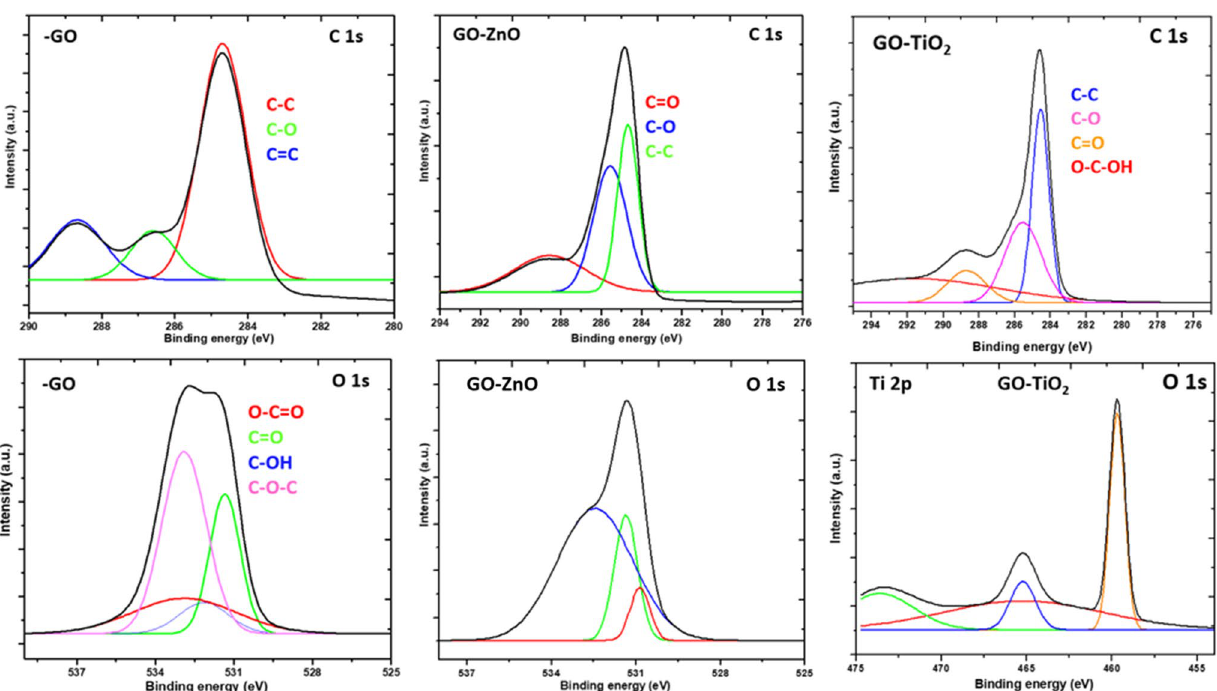
Fig. 3 XPS spectrum of carbon (C) 1 s, and oxygen (O) 1 s of the prepared -GO, GO–ZnO and GO-TiO